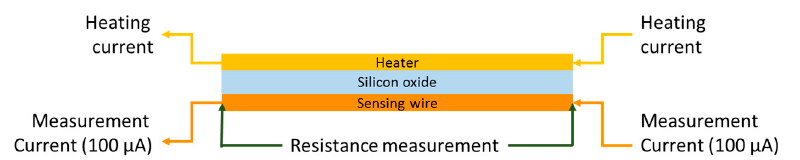
Figure 2. Schematic of the uncoupling between heating and measure, and of the 4-points technique for sensing resistance measurement.